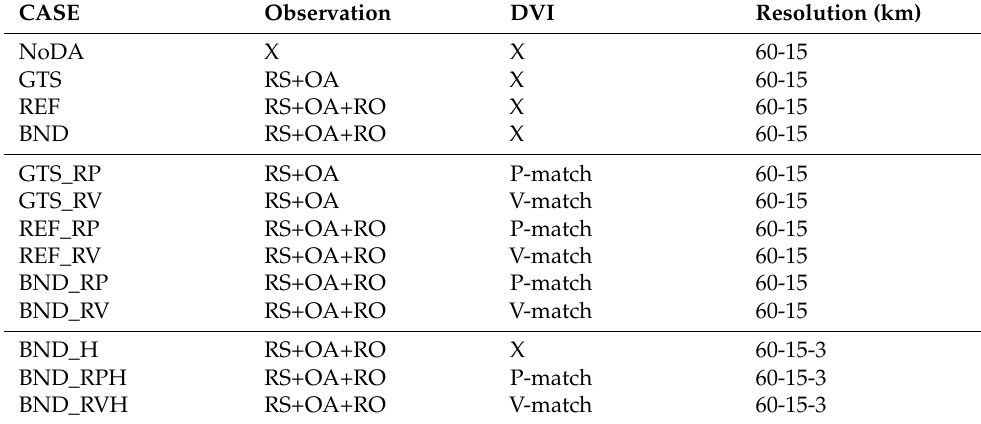
Table 1. Numerical experiments for Typhoon Nepartak (2016). For the experiments, GTS includes the conventional radiosonde soundings (RS), while BND and REF also apply RO bending angle and refractivity soundings, respectively, in addition to the data used in GTS. Note that GTS, BND, and REF used the other observations (OA) (including satellite radiances of AMSU-A and AIRS) routinely available from the CWB. NoDA is the experiment without performing DA (thus, no observations are